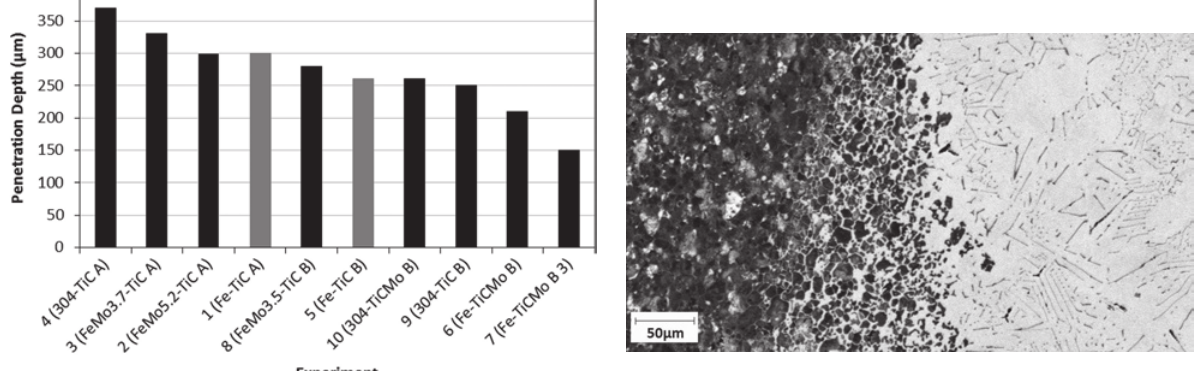
Fig. 8: SEM-BSE image of the penetration zone in experiment 6 (Fe-TiCMo